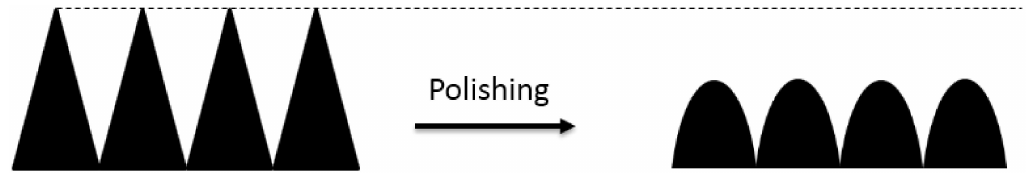
Figure 10. General polishing mechanisms.